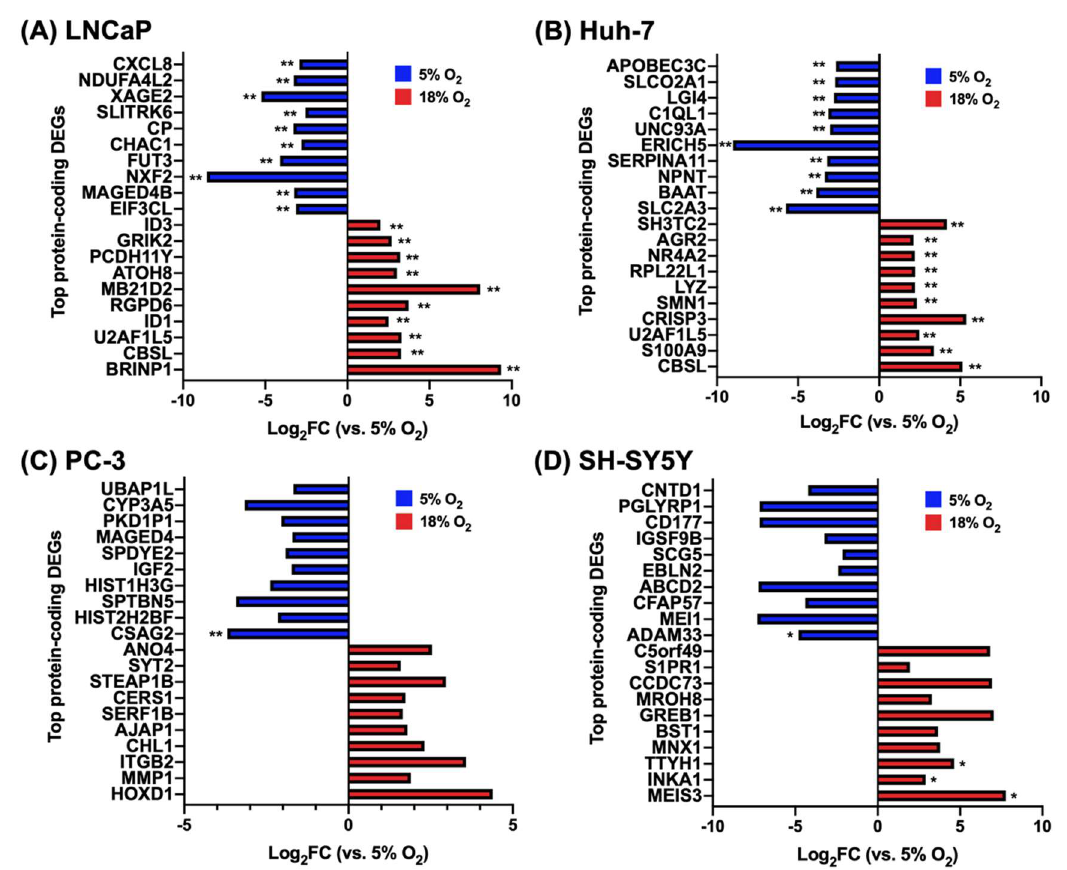
Figure 3. Top 10 protein-coding differentially expressed genes (DEGs) in ( A ) LNCaP cells, ( B ) Huh- 7 cells, ( C ) PC-3 cells, and ( D ) SH-SY5Y cells at 18% O 2 vs 5% O 2 . (* p adj < 0.05, ** p adj < 0.005, otherwise p <